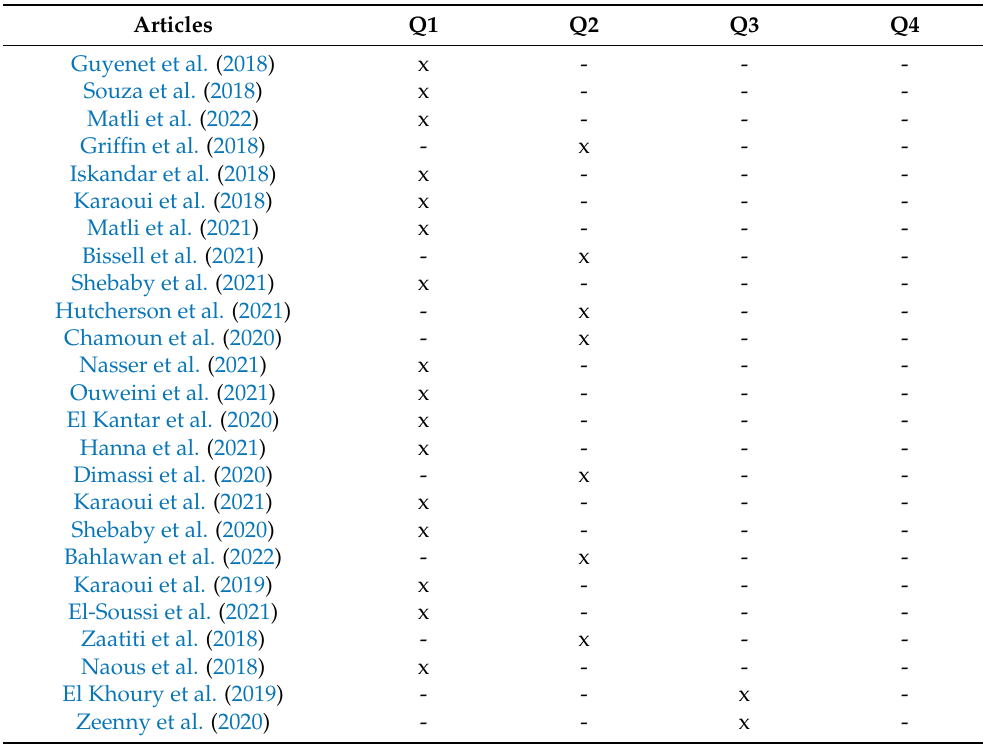
Table A4. Published papers in the School of Pharmacy per quartile,